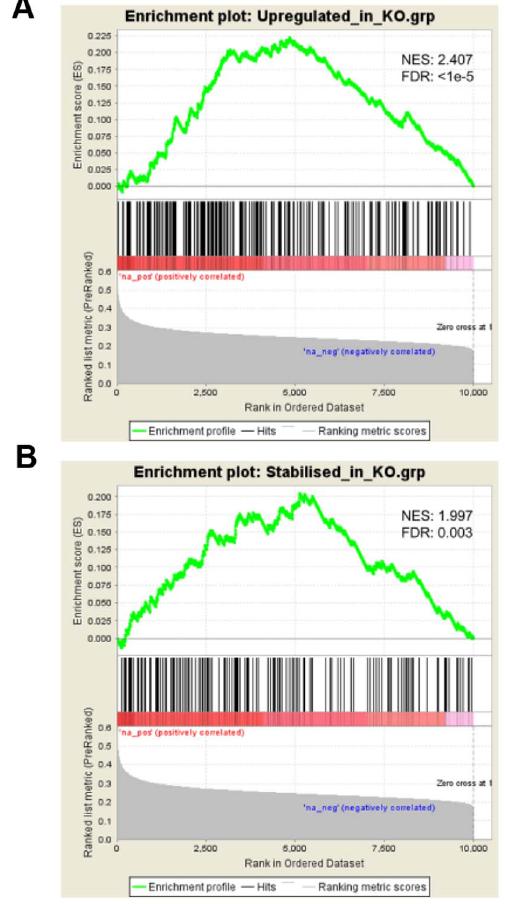
Figure 1. Validation of ZFP36 target genes inferred from MIC analysis of microarray gene expression data. Gene set enrich- ment analysis [20] profiles are shown for 10016 genes, rank-ordered by MIC score. Normalised Kolmogorov-Smirnov enrichment scores (NES) and false discovery rate q values (FDR) are shown. (A) using a gene set (n=237) representing mRNAs that are significantly up-regulated in Tis11/ZFP36 -knock-out mouse fibroblasts [21], (B) using a gene set (n=152) representing mRNAs that display a significantly decreased rate of degradation in Tis11/ZFP36 -deficient mouse fibroblasts [22].